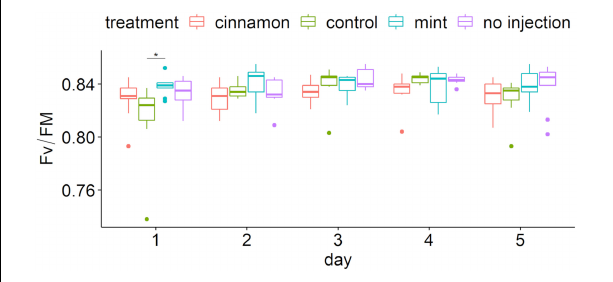
FIGURE 8 | Maximum quantum yield of photosystem II (Fv/Fm) boxplot per treatment during time after injection. The star symbols above the bars indicate a significant difference between the means ( P <